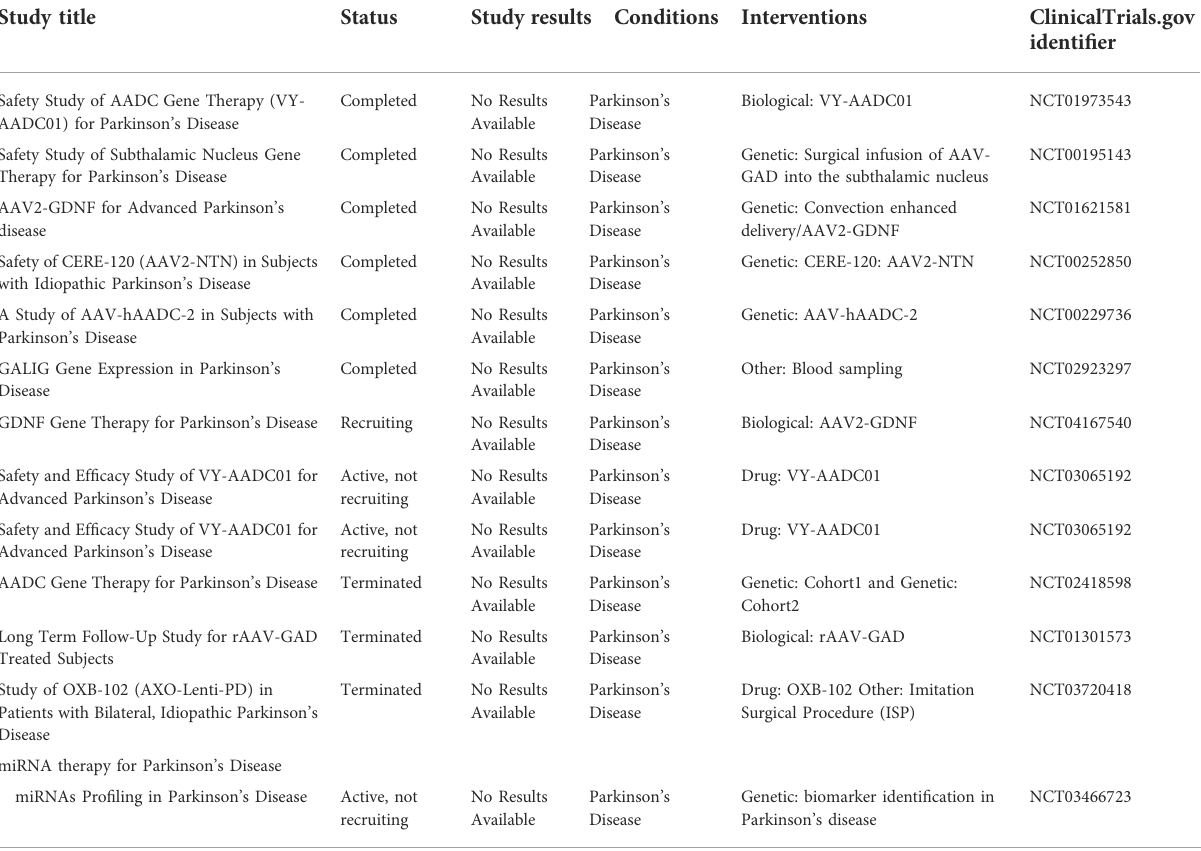
TABLE 3 Clinical trial data of gene therapy for Parkinson ’ s